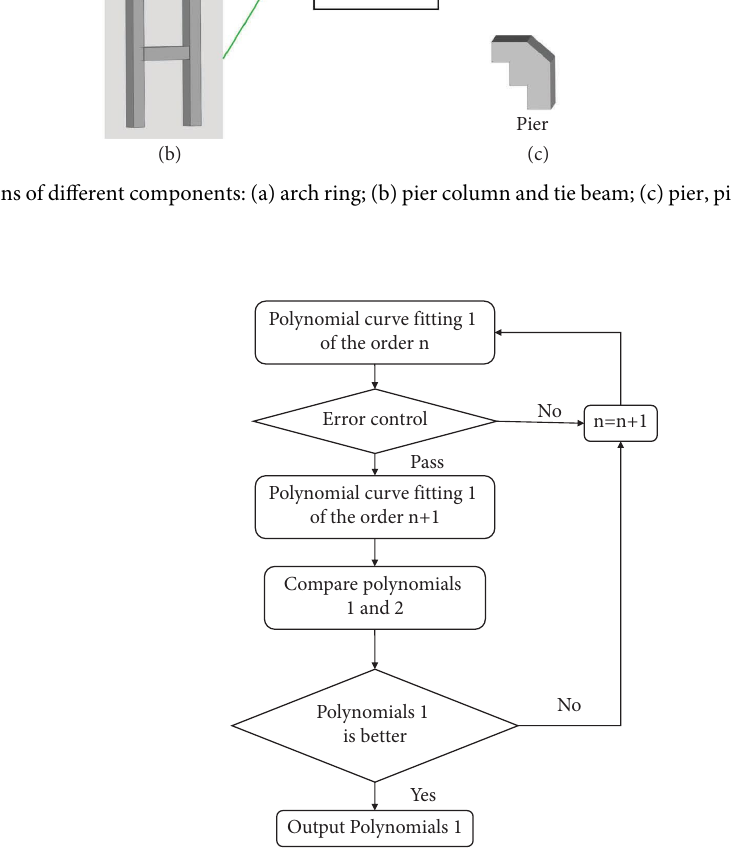
Figure 3: Process of the iterative polynomial ftting